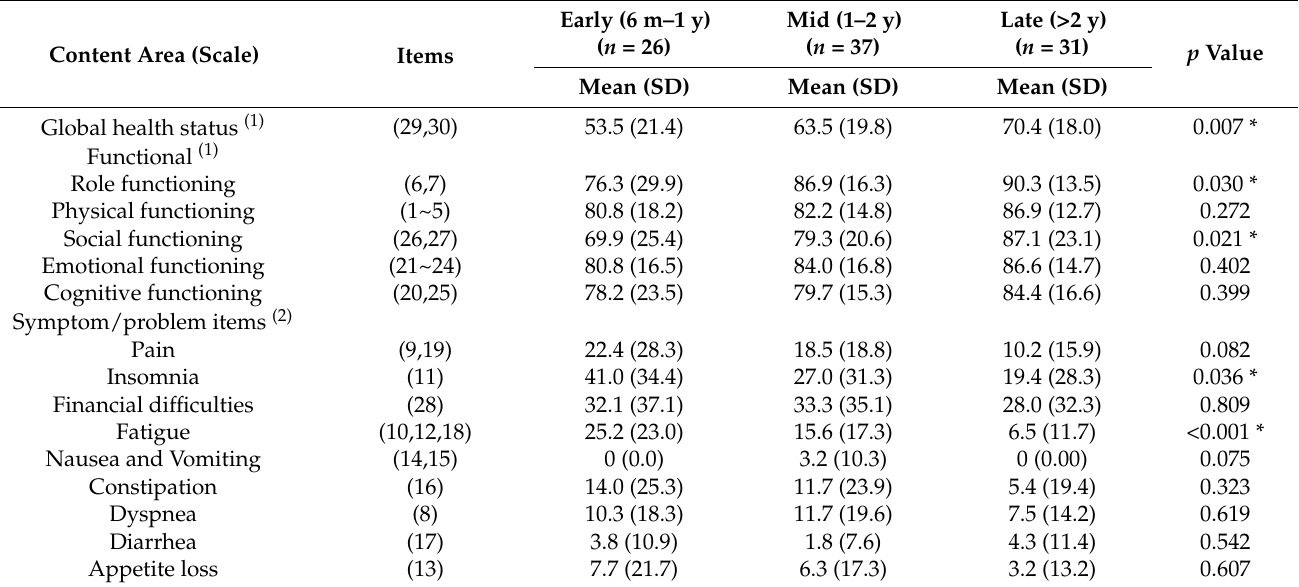
Table 2. Assessment of patients’ quality of life with the European Organization for Research and Treatment of Cancer Quality of Life Questionnaire C-30 (EORTC QLQ-C-30) following anterolateral thigh flap surgery. SD: standard